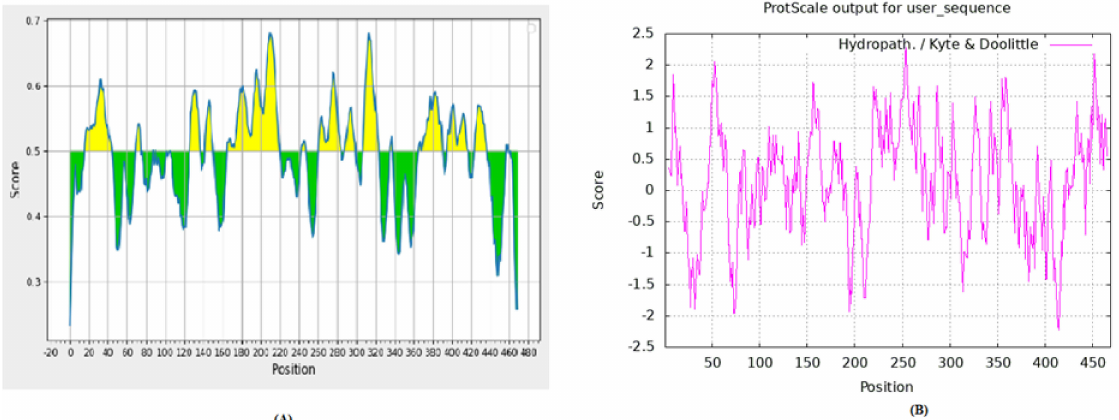
Figure 1. ( A ) The figure represents the B − cell epitope prediction in the hypervariable region of VP2 by BepiPred − 2.0: Sequential B − cell Epitope Predictor. Amino acids sequence was fed to IEDB tools for B − cell epitope prediction. The yellow color represents the epitopes above the threshold while green ones are below the threshold value. Epitopes were selected from the hypervariable region having values above 0.5 thresholds. ( B ) The figure represents the hydrophobicity index of full − length VP2 by Hydropath/Kyte & Doolittle method. Amino acids in the hypervariable region represent values above the threshold of 0.5.